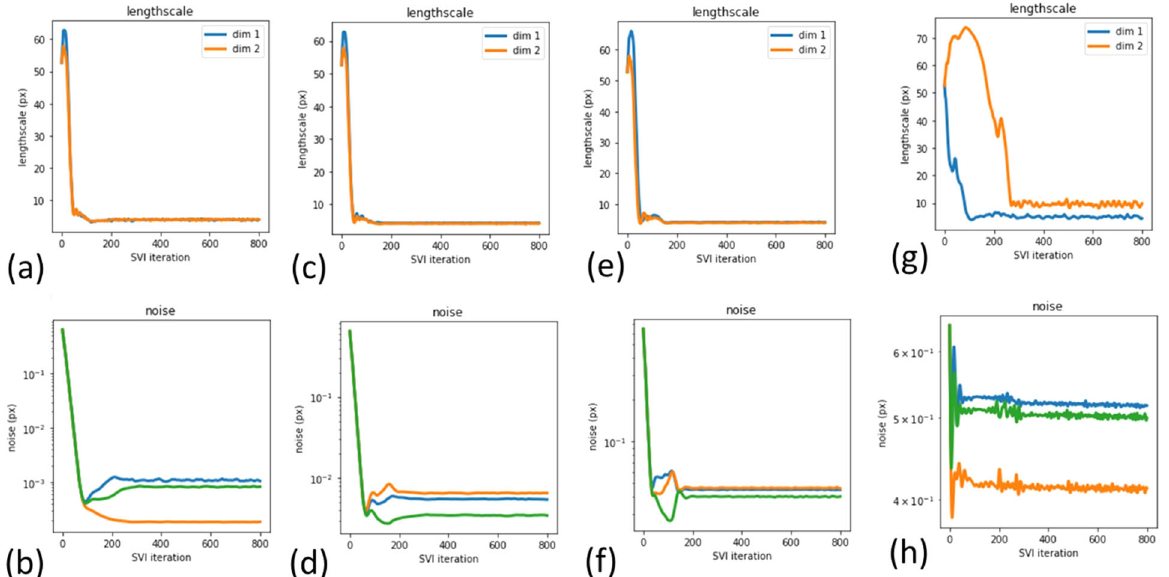
Fig. 5 Evolution of the multivariate GP training for different noise levels with anisotropic unconstrained kernel. Shown are the results for the 3-component synthetic data set in Fig. 4. The dim 1 and dim 2 are the kernel length scales associated with the x and y image dimensions. Shown a , c , e , g is kernel length scale evolution and b , d , f , h noise evolution. The GP is performed for noise levels a , b σ = 0.03, c , d σ = 0.1, e , f σ = 0.3, and g , h σ = 1. 1.